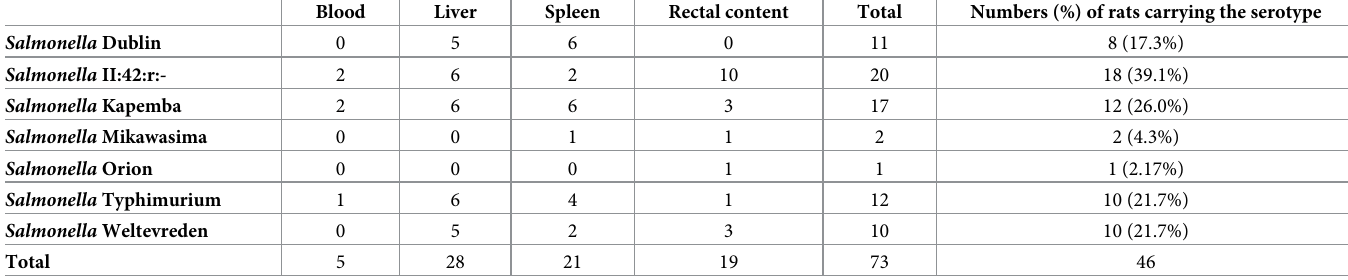
Table 2. Serotypes of rats (n = 46) according to specimen. First isolate per serotype per specimen. A total of 73 single non-duplicate Salmonella serotype isolates were recovered from 46 rats; multiple serotypes were observed in 13 rats. Specimens listed were sampled for each rat, except for blood which was sampled for 218/566 (38.5%)